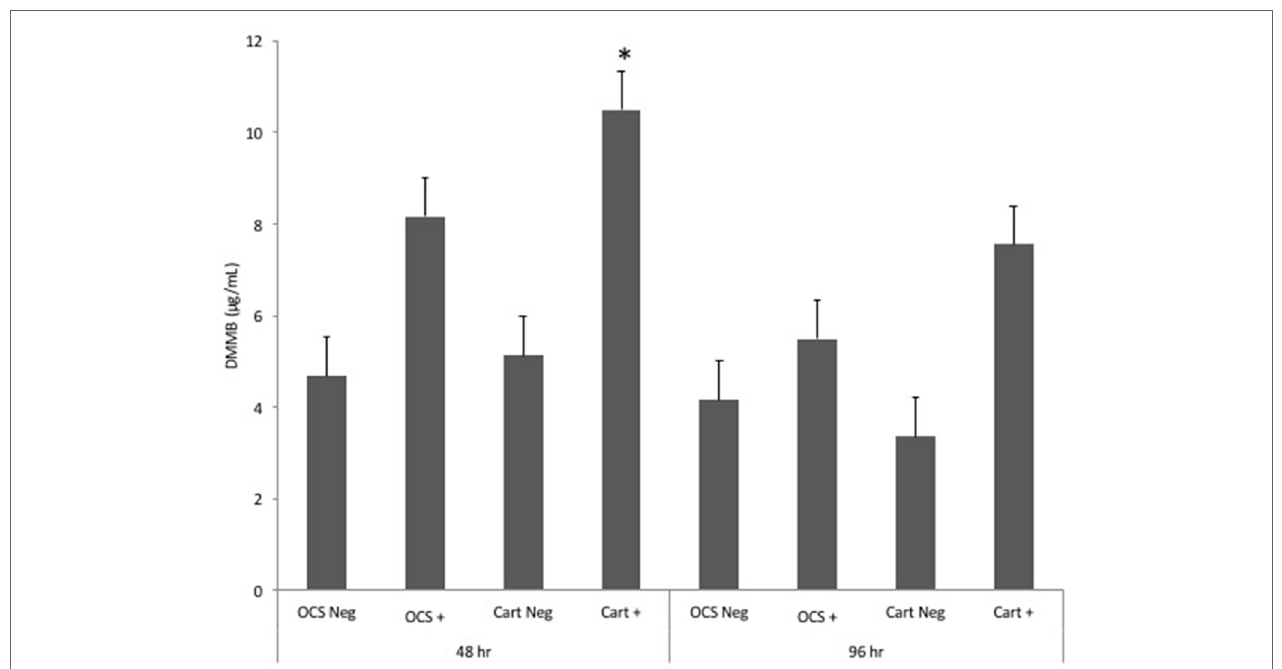
FigUre 4 | Mean ± SE concentrations of dimethyl-methylene blue (DMMB) in media samples of cultures containing osteochondral and synovial explants (OCS) or cartilage explants alone (Cart) that were unstimulated (Neg) or stimulated with IL-1 (10 ng/mL; + ) at 48 and 96 h after initiation of